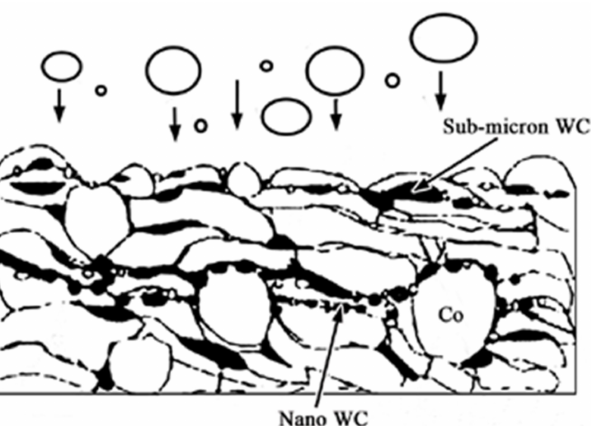
Figure 6. Sketch map of the formation of coarse and fine WC particles in the multimodal coating, adapted from